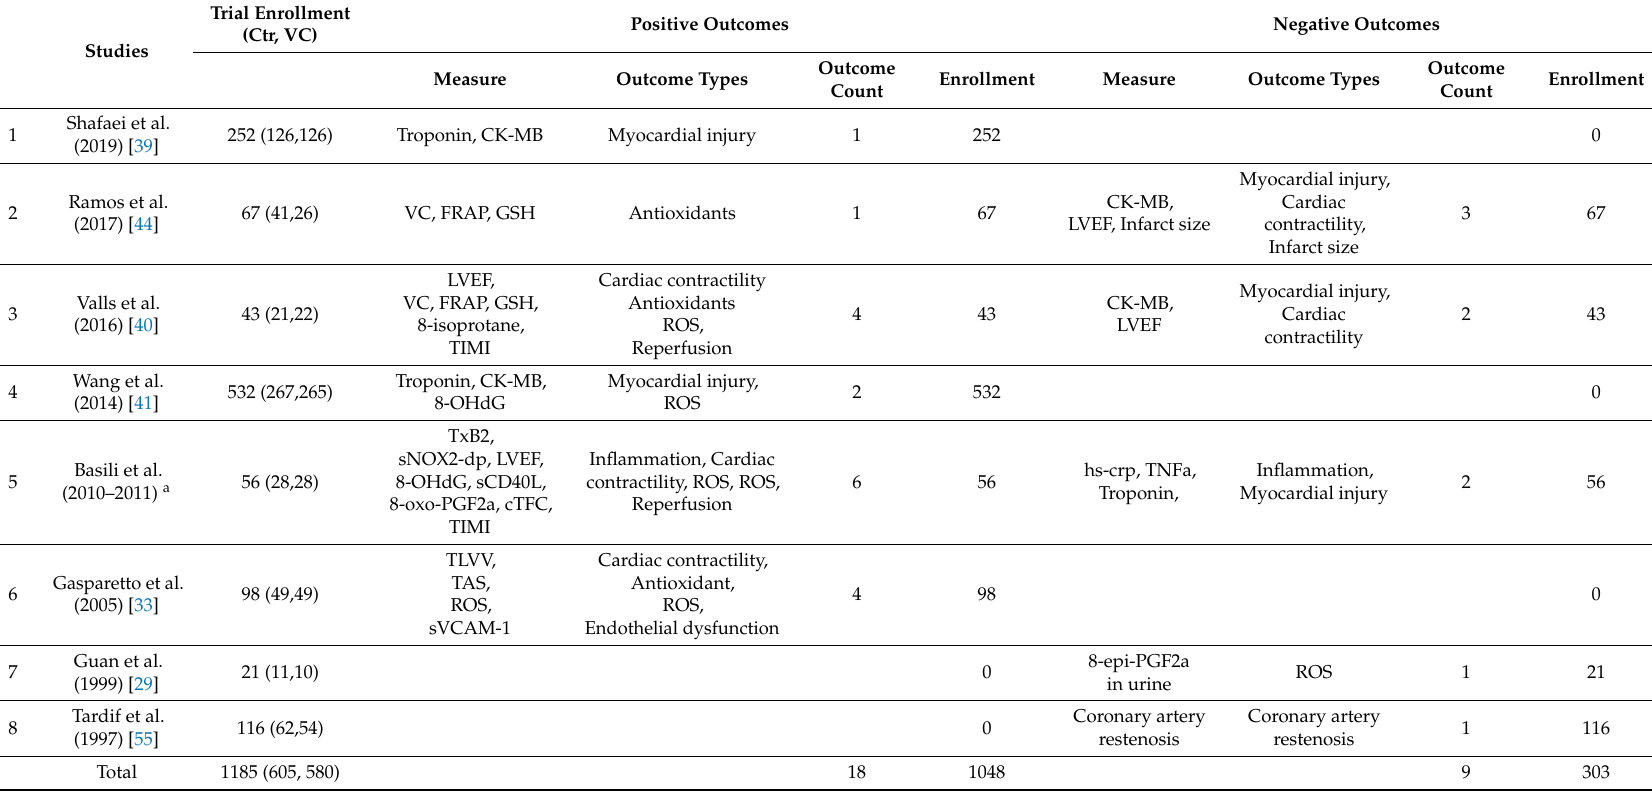
Table 6. Summary of All